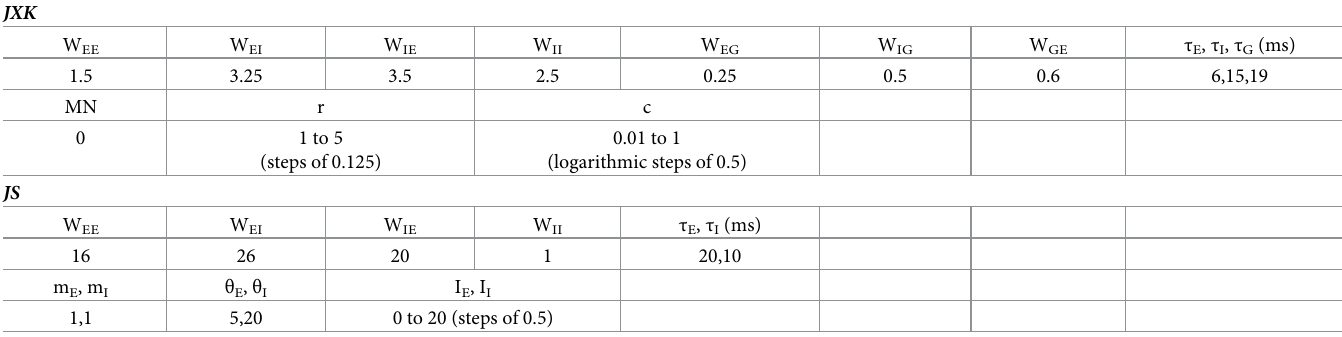
Table 1. Parameter values used in rate